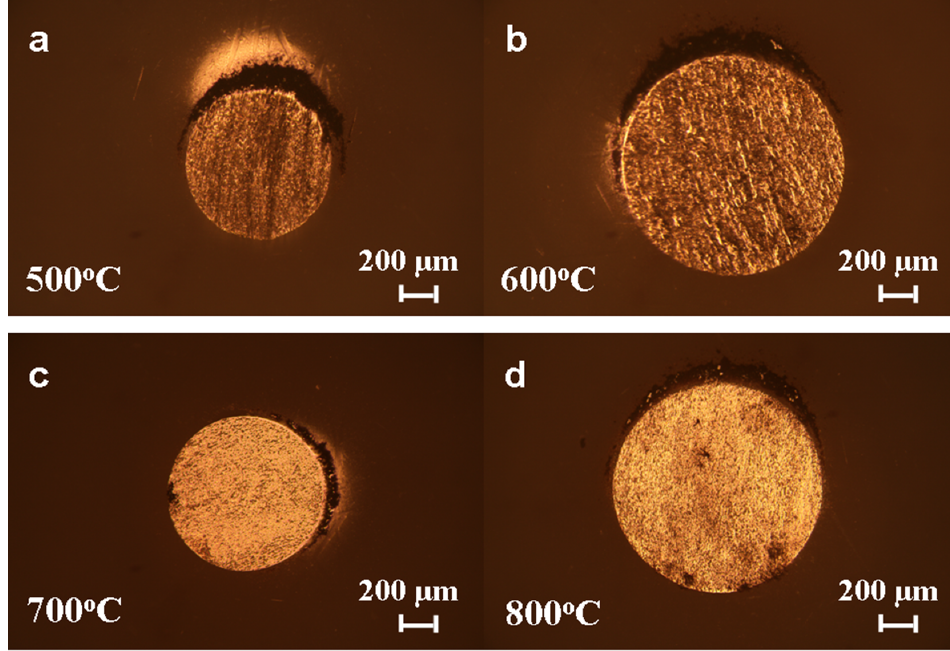
Figure 9. Optical images of ZrO 2 ball worn surface under different temperatures: ( a ) 500 °C, ( b ) 600 °C, ( c ) 700 °C and ( d ) 800 °C.